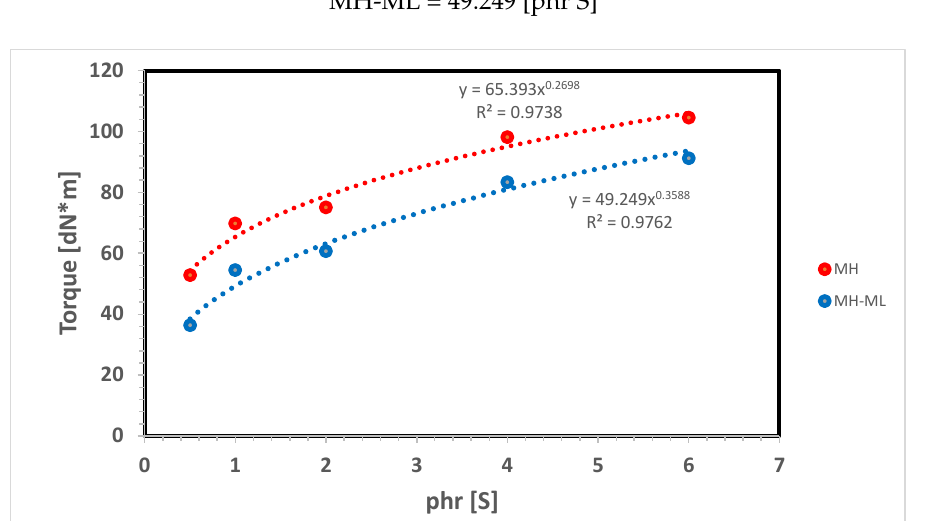
Figure 2. Maximum rheometer torque (MH) and delta torque (MH-ML) measured on the five compounds of Table 1. The rheometer test was run for 8 min at 175 °C. The torque values grow following the amount of sulfur added, implying a higher crosslinking density.